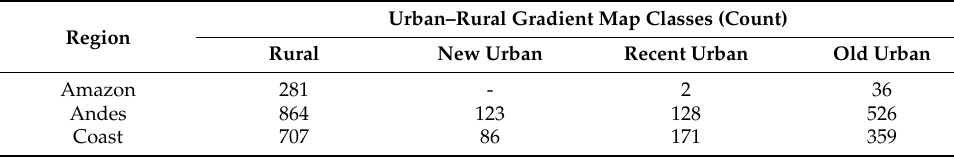
Table 4. High schools by region and urban–rural gradient map classes.